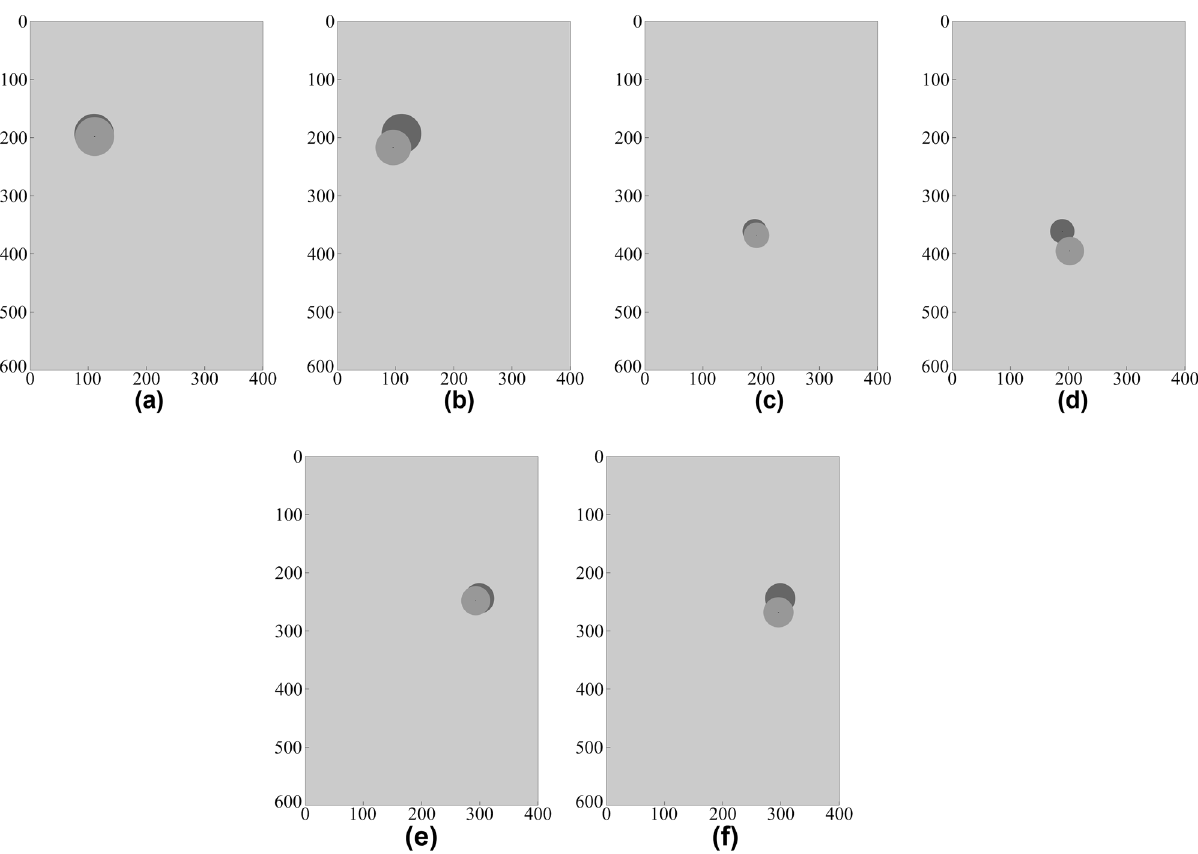
Figure 12. Prediction of geophysical parameters of the object, obtained using the proposed surrogate model and the benchmark techniques (all using the DS4 dataset). The target and surrogate-predicted object marked using the dark- and light-grey shade, respectively: Scenario I: D = 193 mm, P = 110 mm, R = 34 mm, ( a ) proposed model, ( b ) CNN; Scenario II: D = 361 mm, P = 189 mm, R = 21 mm, ( c ) proposed model, ( d ) MLP; Scenario III: D = 244 mm, P = 299 mm, R = 26 mm, ( e ) proposed model, ( f )